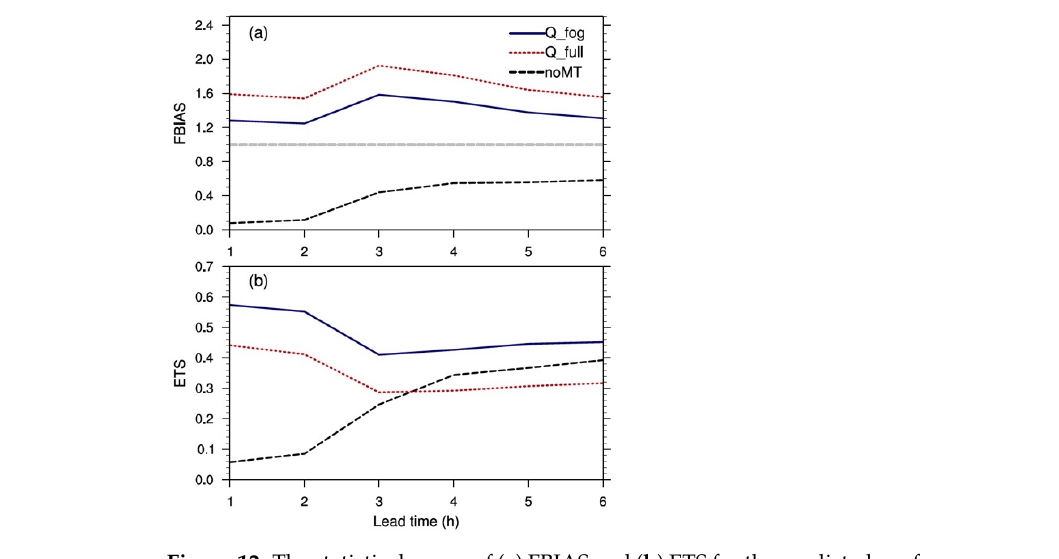
Figure 12. The statistical scores of ( a ) FBIAS and ( b ) ETS for the predicted sea fog coverage aggre ‐ gated over the 6 ‐ h free forecasts initialized at each hour during the DA period from Case07, Case09, and Case15 for noMT, Q_full, and Q_fog.